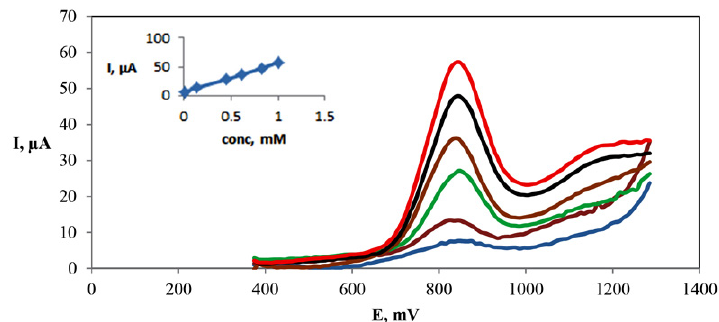
Figure 8. SWV of SLC over the concentration range from 0.005 to 1.0 mM in BR pH 7.0 containing 0.03 mM SDS using 40% Table 3. determination of SLC in pharmaceutical dosage form and statistical comparison of the proposed voltammetric and the published HPLC method 5